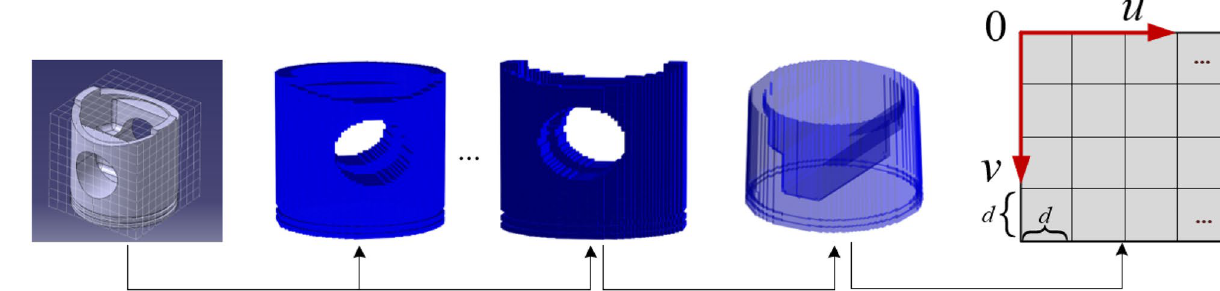
Figure 9. Part geometry